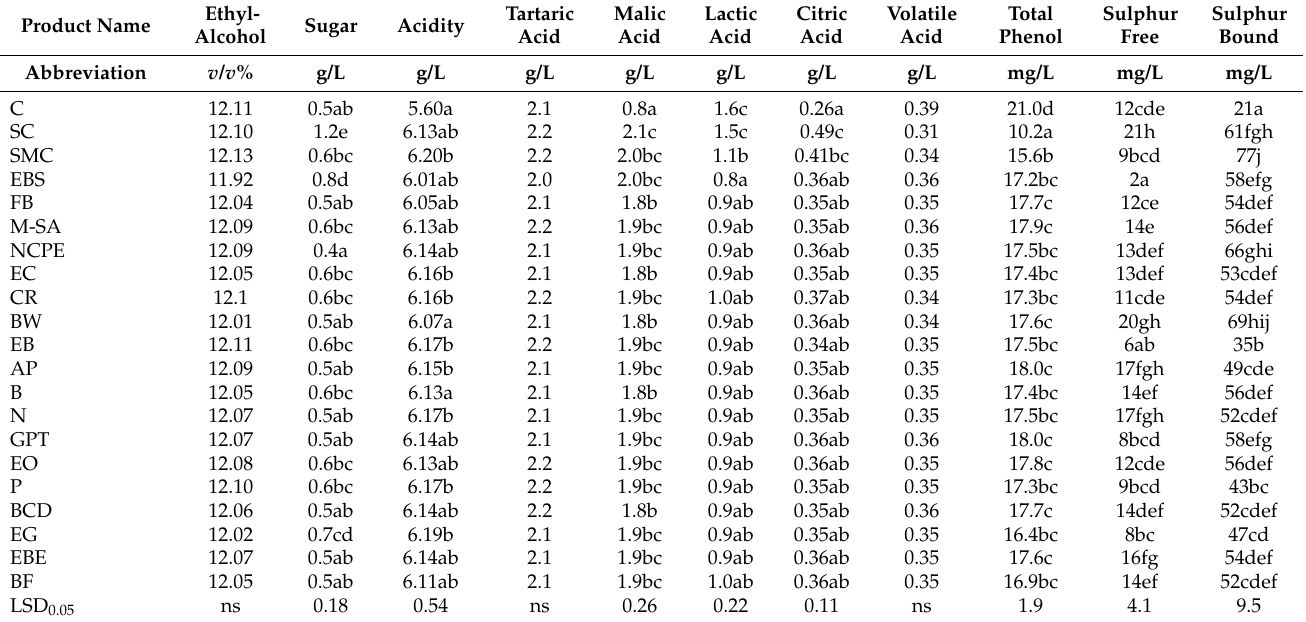
Table 3. Quantities of nine basic wine parameters (ethyl-alcohol, sugar, acidity, tartaric acid, malic acid, lactic acid, citric acid, volatile acid, and total phenol) in white wine samples treated with twenty- one bentonite products including control treatments (Debrecen-Pallag, Hungary). Different letters within each column are significantly different among the bentonite product treatments at p = 0.05 according to LSD t-tests (LSD 0.05 ). ns = nonsignificant. Explanations for bentonite product name abbreviations are given in Table